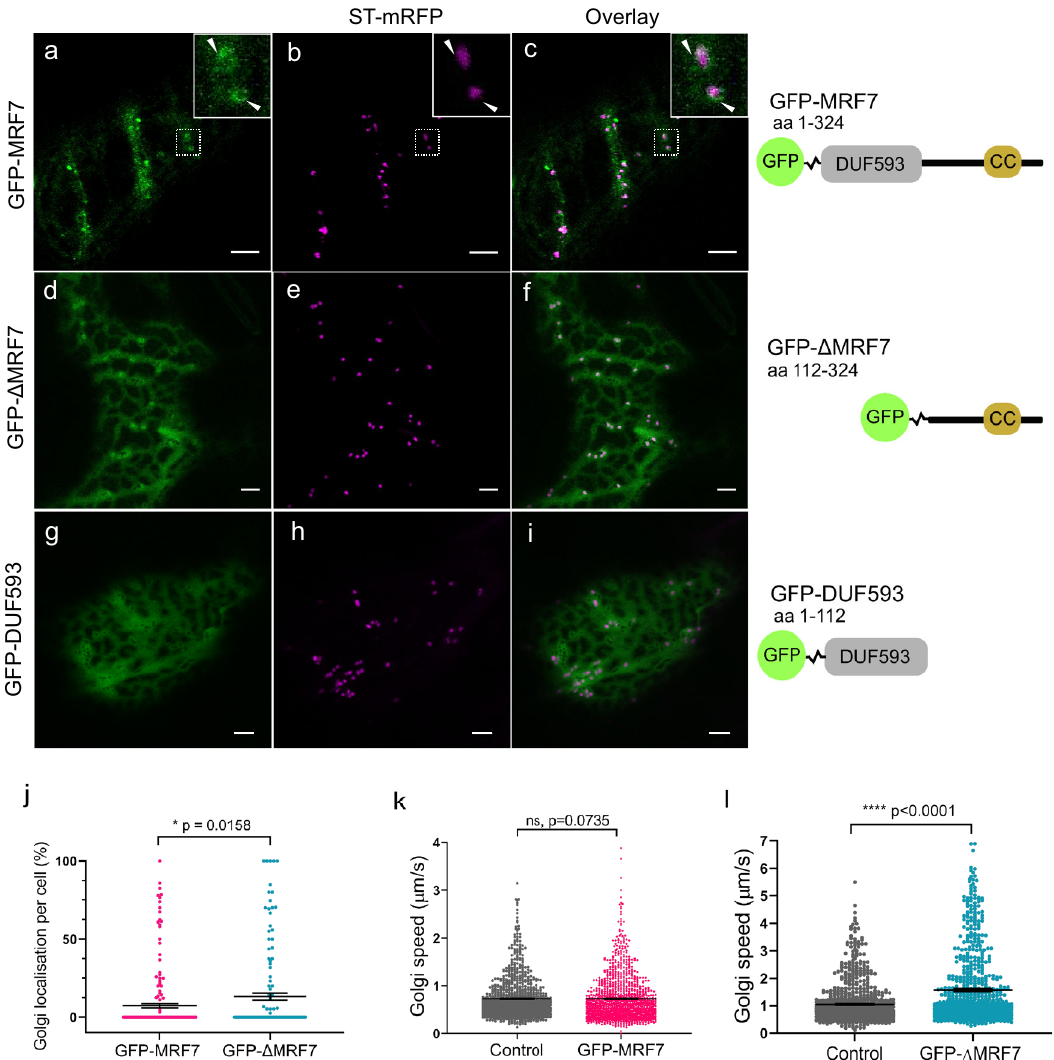
Fig. 2 DUF593-independent Golgi localisation of MRF7 and effects on Golgi movement. Transient expression of full-length and truncated MRF7 (green) with the Golgi marker ST-mRFP (magenta) in tobacco leaf epidermal cells. Schematics on the right hand-side of each panel show the architecture of the truncations used in this study; DUF593 Domain of Unknown Function 593, CC coiled-coil. a – c In addition to the punctate localisation shown in Fig. 1, GFP- MRF7 exhibits Golgi surface localisation. Smaller panels in the right hand-side provide a magni fi cation of the region indicated by the dotted square. Arrowheads indicate the Golgi surface localisation of GFP-MRF7. d – f Absence of the DUF593 domain does not impair the Golgi localisation of MRF7. g – i The DUF593 domain itself is cytosolic and does not colocate to Golgi. j Signi fi cant increase in Golgi localisation in cells expressing GFP- Δ MRF7 compared with GFP-MRF7. Each datapoint represents the percentage of Golgi in a particular cell. Mann – Whitney test, data collected from 207 (GFP- MRF7) and 143 (GFP- Δ MRF7) cells across at least 16 independent in fi ltrations. Bars represent mean ± SEM. Golgi speed was analysed in cells expressing Golgi marker and either GFP-MRF7 ( k ) or GFP- Δ MRF7 ( l ). Bars represent mean ± SEM. GFP-MRF7 does not signi fi cantly in fl uence Golgi movement ( n = 1185, 40 cells, 4 independent experiments) when compared to control cells expressing Golgi marker alone ( n = 1000, 40 cells, 4 independent experiments). GFP- Δ MRF7 signi fi cantly increases Golgi speed ( n = 717, 36 cells, 5 independent experiments) when compared to control cells expressing Golgi marker alone ( n = 855, 42 cells, 5 independent experiments). Mann – Whitney test. All imaging carried out in tobacco leaf epidermal cells two days post-in fi ltration. Scale bar = 5 μ